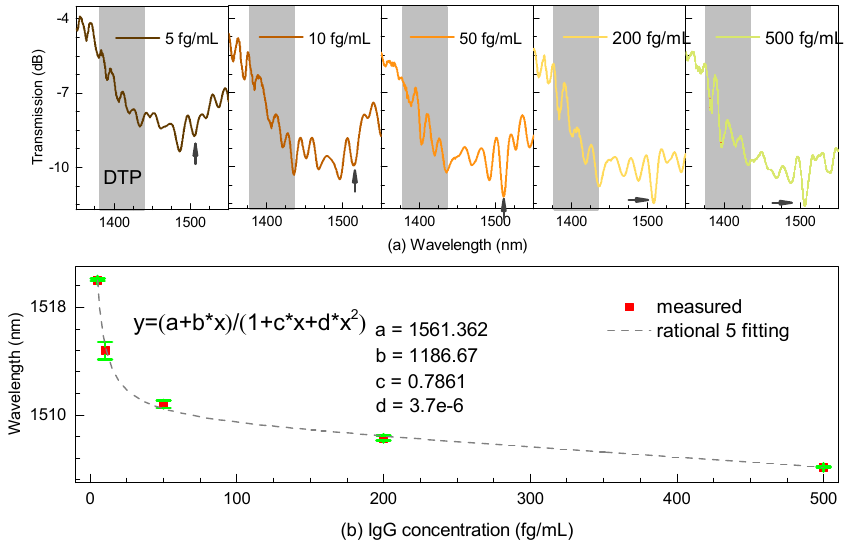
Figure 6. ( a ) Transmission spectral responses near the DTP. ( b ) Resonant shift with different concentrations of IgG.